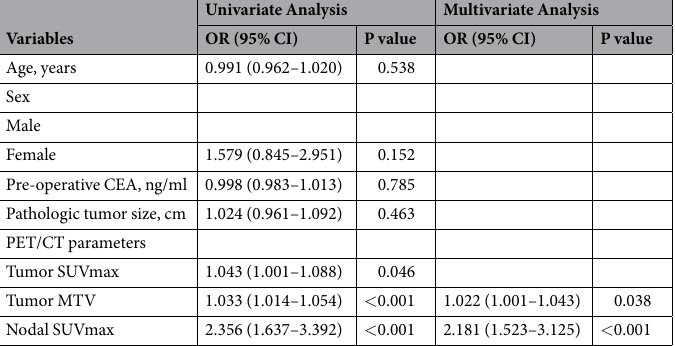
Table 2. Uni- and multivariate logistic regression analyses for regional lymph node metastases. OR = Odds Ratio; CI = Confidence Interval; CEA = Carcinoembryonic Antigen; PET/CT = Positron Emission Tomography/Computed Tomography; SUVmax = maximum standardized uptake value; MTV = Metabolic Tumor Volume.